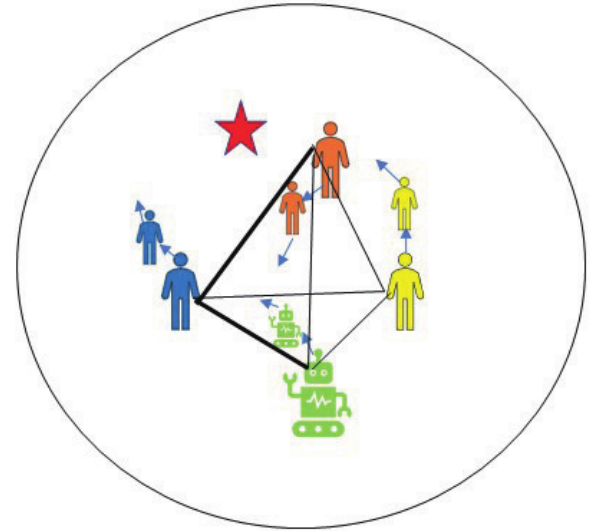
Figure 1. Robot and human interaction